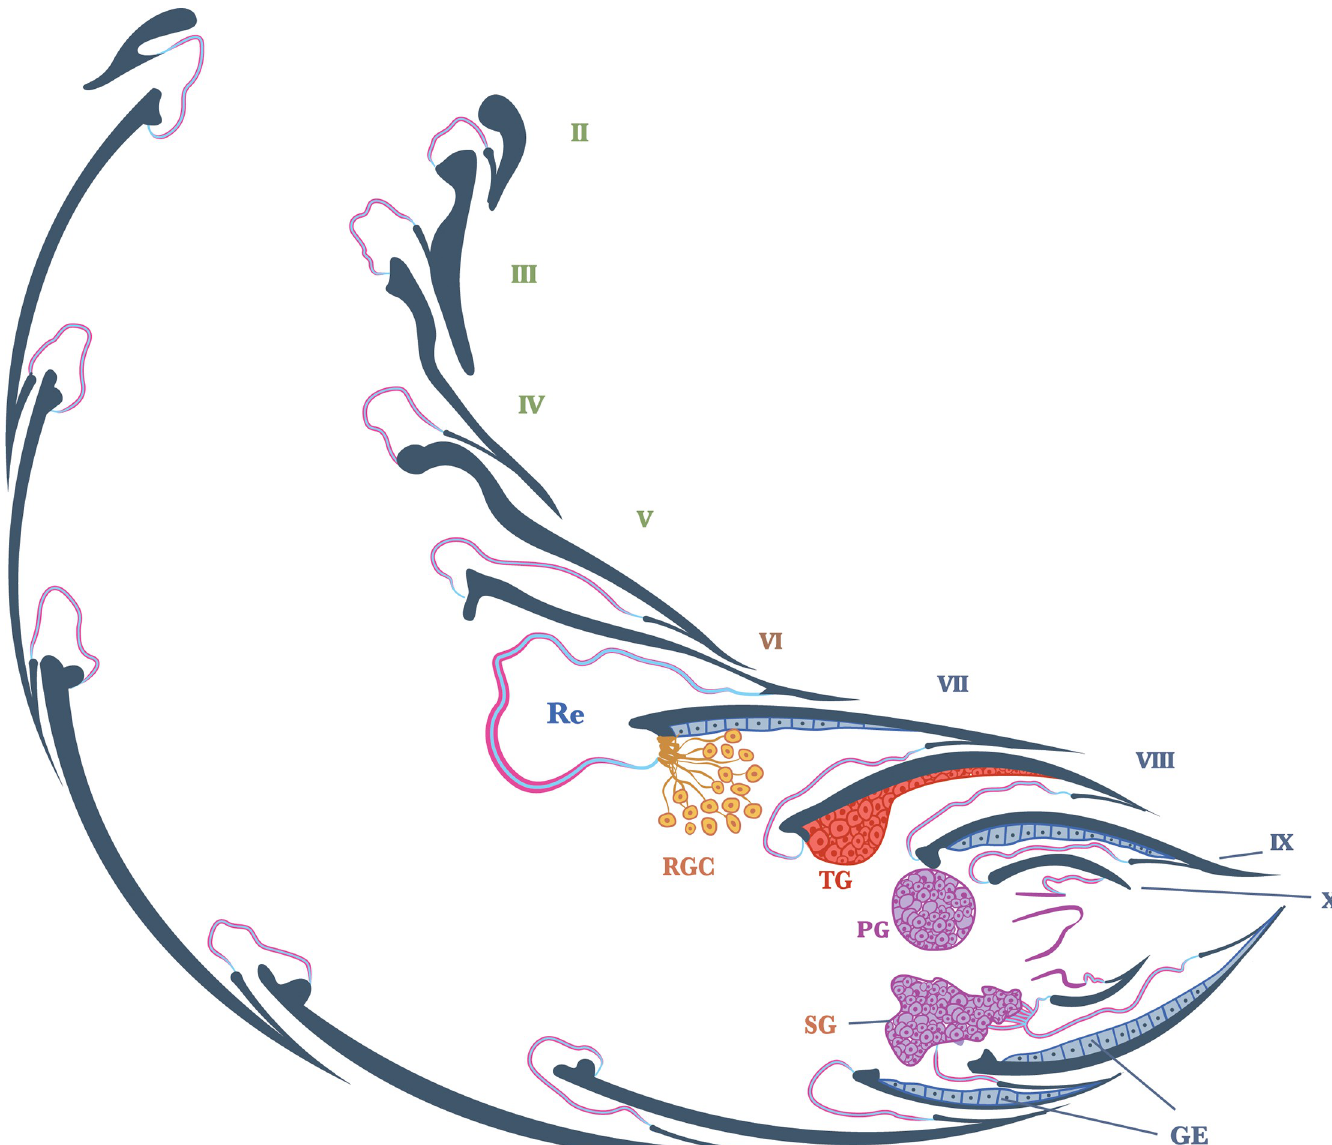
Fig 8. Schematic illustration of the exocrine glands in the abdominal tip of Dinarda dentata . RGC, defense repellent gland cells; Re, reservoir of dense repellent gland; TG, tergal gland in 8 th abdominal tergite; PG, pleural gland; SG, sternal gland; GE, glandular epithelium.